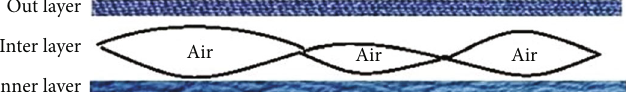
Figure 6: Style diagram.